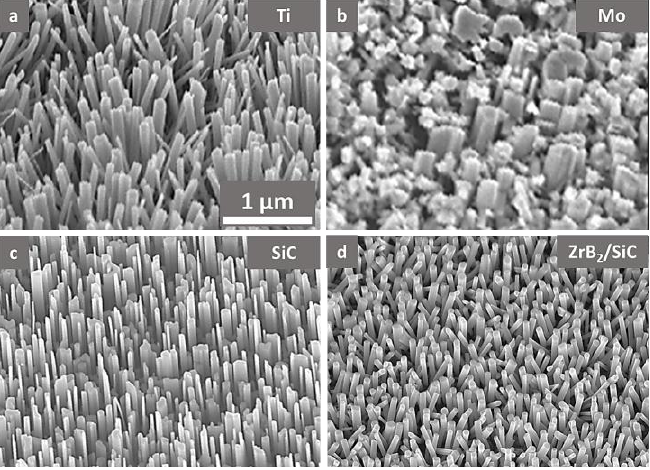
Figure 5. Tilted-view SEM images of GaN NRs grown on various template/substrates ( a ) polycrystalline Ti, ( b ) polycrystalline Mo, ( c ) SiC, and ( d ) ZrB 2 /SiC. The figures have the same